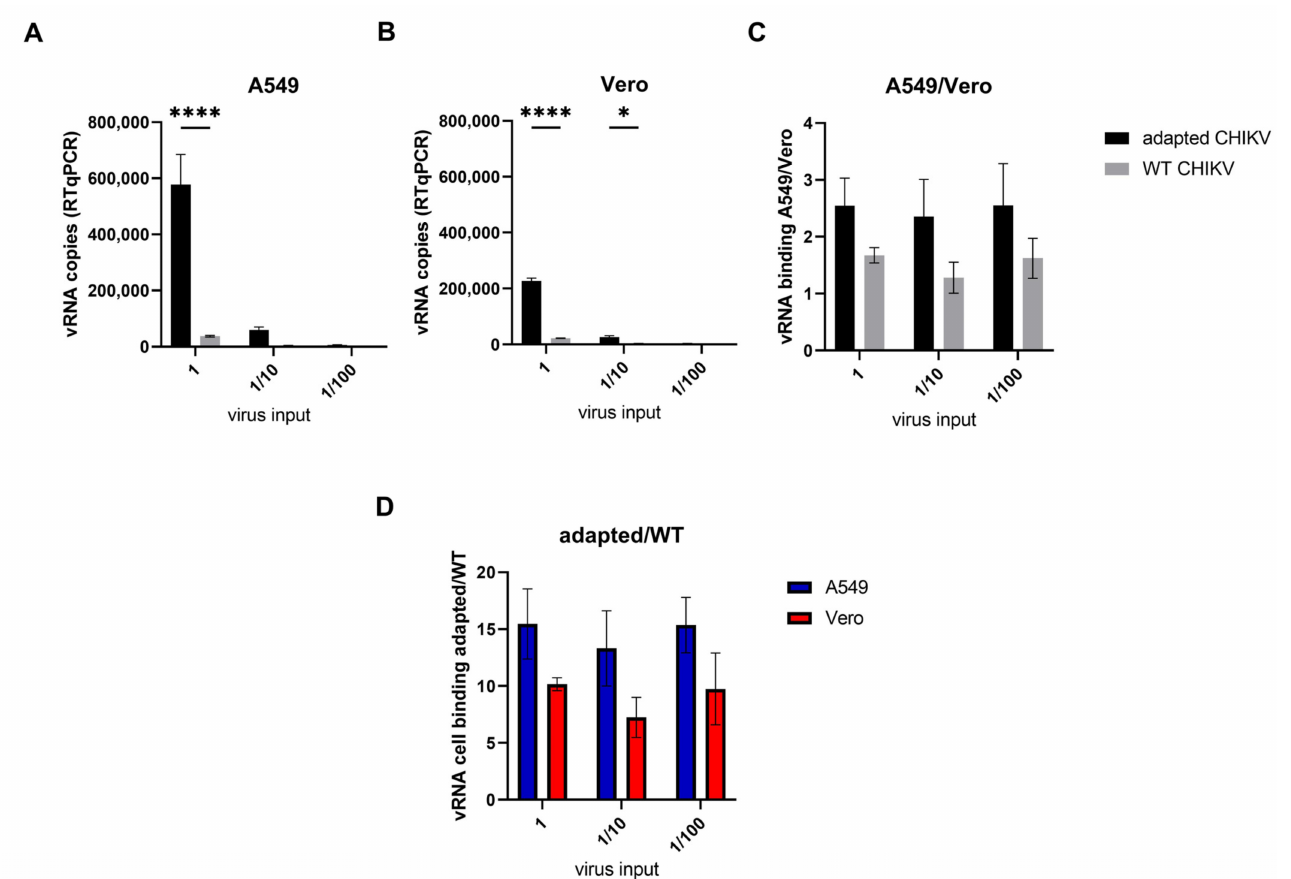
Figure 5. Binding assay to evaluate attachment of WT and E2 adapted virus carrying T196K and H232R mutations to A549 and Vero cells. ( A ) Binding of WT and adapted virus to A549 cells ( B ) Binding of WT and adapted virus to Vero cells ( C ) Ratio of virus binding A549/Vero cells is shown for WT and adapted virus. ( D ) Ratio virus binding adapted/WT is shown for both A549 and Vero cells. Three 10-fold dilutions of CHIKV were incubated with each cell line. Equal amounts of viral genomic RNA were used for the WT and adapted CHIKV. Mean ± SD is shown. Two-way ANOVA with Šid á k multiple comparisons was performed * = p < 0.05 and **** = p <